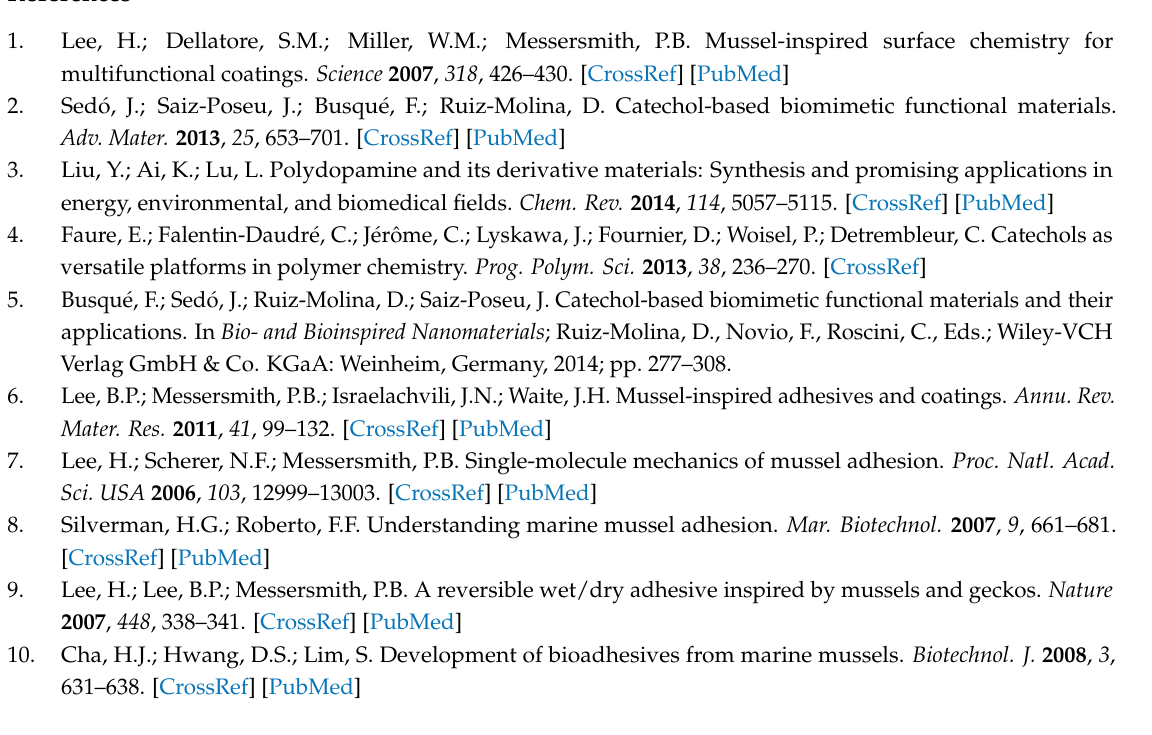
Figure S1: Production of the freestanding multilayer membranes; Video S1: Adhesiveness of the freestanding membranes to a clean surface of porcine